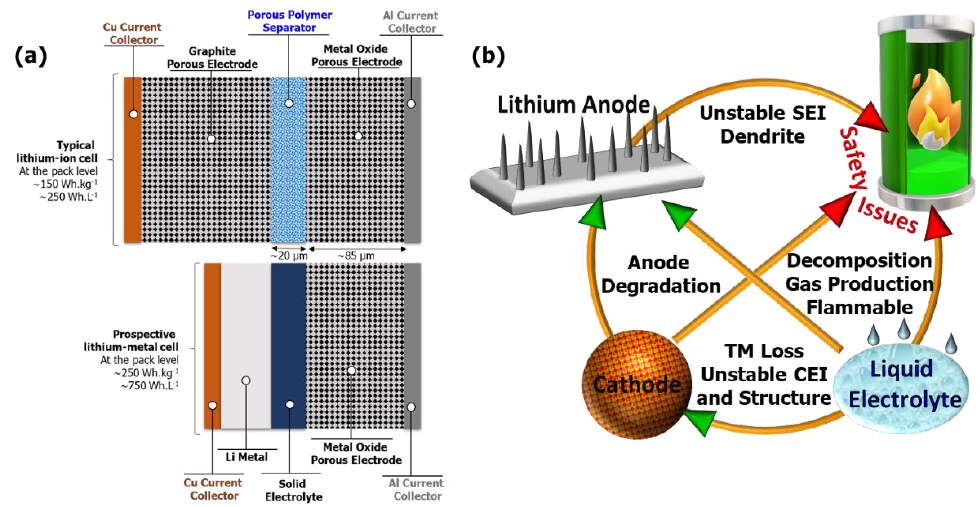
Figure 6. ( a ) A typical Li-ion cell (top) and a lithium metal cell (bottom) containing a solid separator and a dense layer of metallic lithium. ( b ) Failure mechanisms and safety hazards of Li-metal anodes using conventional liquid electrolytes. Table 2. Processing routes for anode materials, including their advantages and challenges.